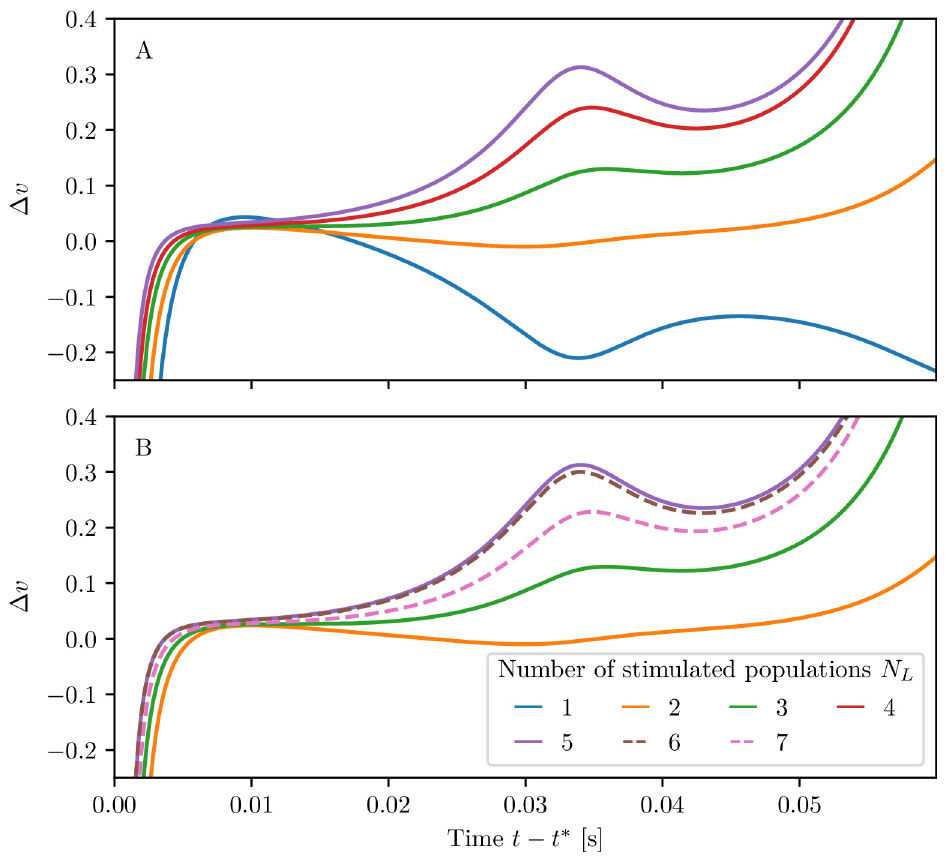
Fig 12. Dependence of the membrane potential difference on the number of loaded items. Difference Δ v of membrane potentials versus time when stimulating different numbers N aligned to t � , which marks the deliverance of a PB from population one. The populations are stimulated sequentially with parameter values as in Fig